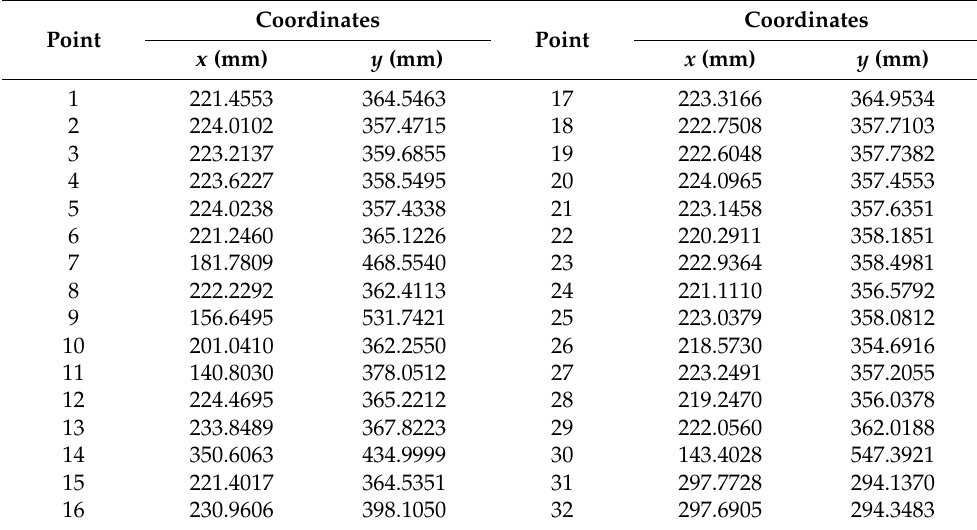
Table 8. Coordinates of the experimental intersections of two groups of 4 sensors under Case I.